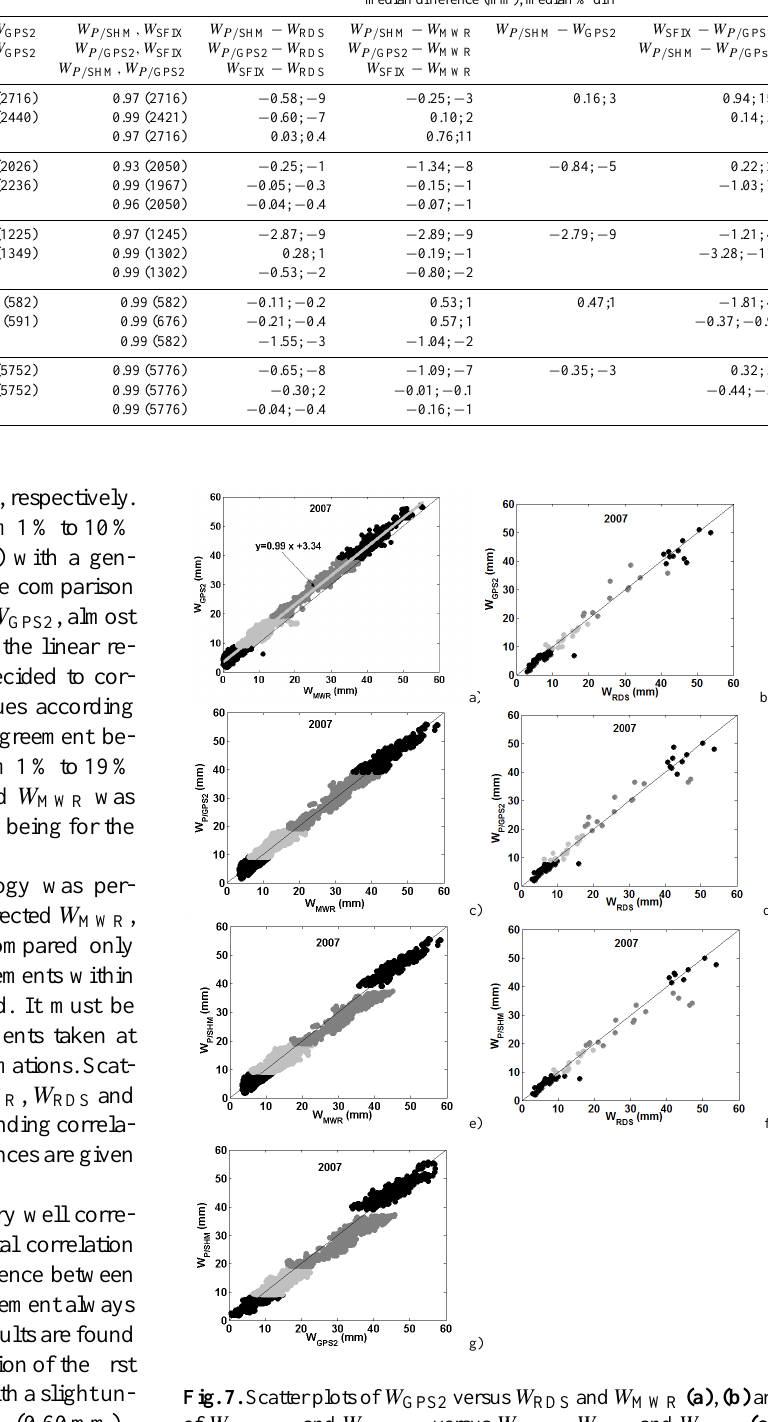
Table 3. Correlation coefficients and median difference among W P/ SHM ,W P/ GPS2 , W S , and measurements taken by GPS, microwave radiometer and radiosondes. R 2 ( N points )